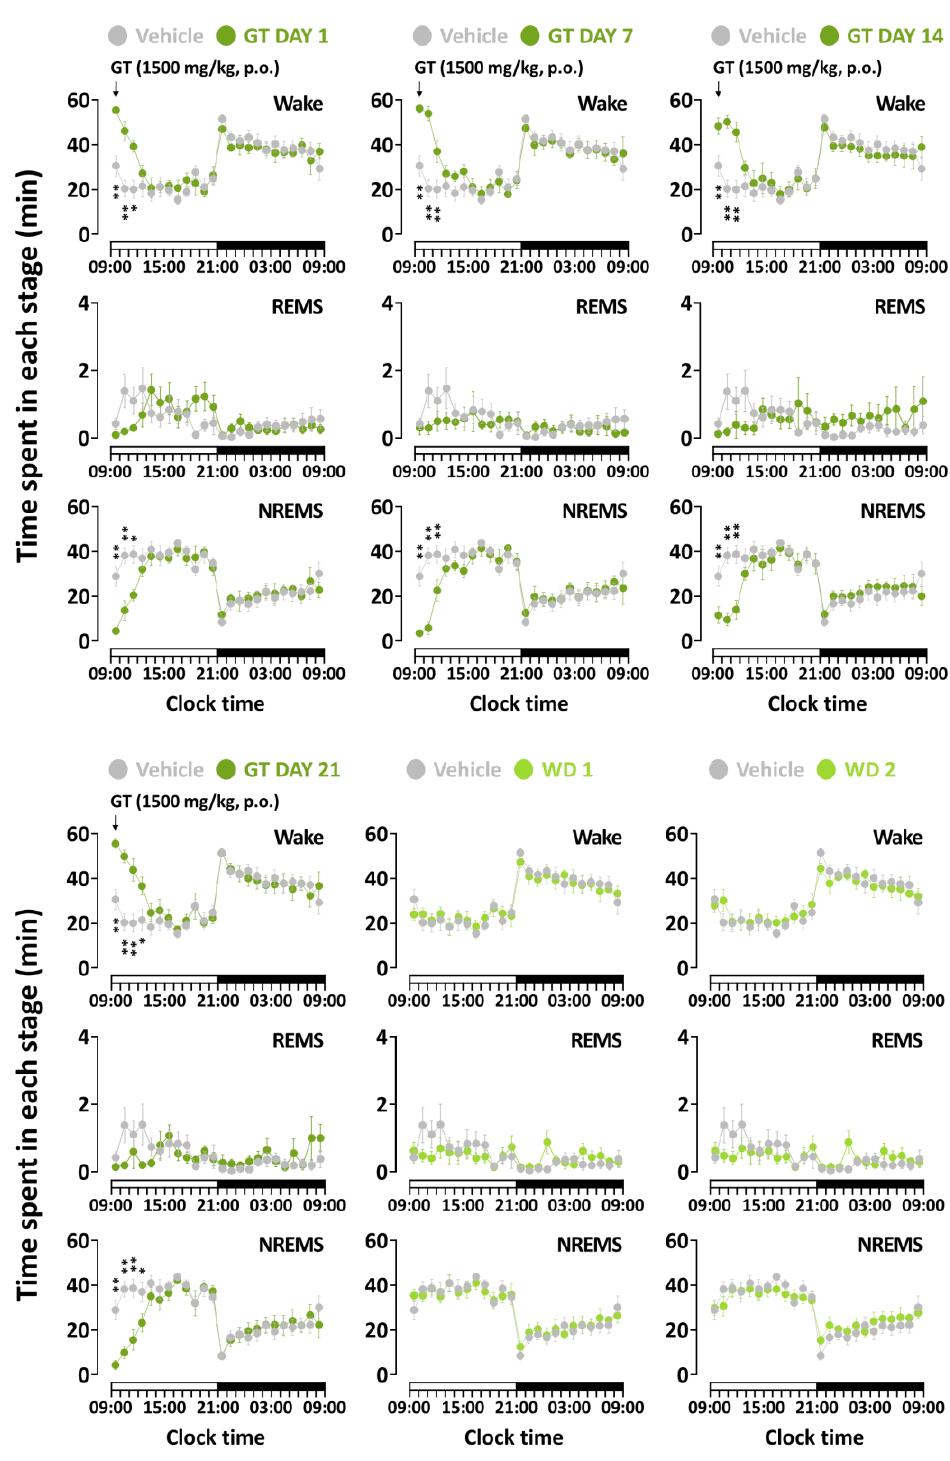
Figure 4. Time-course changes of GT (1500 mg/kg) treatment during each stage over the whole administration period. Grey circles indicate the baseline day (vehicle). Green circles illustrate GT treatment. Light green circles illustrate the withdrawal (WD) day during the end of GT treatment. Every circle denotes the hourly mean ± SEM ( n = 7 – 8) in each stage. * p < 0.05, ** p < 0.01 indicate significant differences compared to the vehicle (Dunnett’s test). BL, ba seline; GT, green tea ethanol extract; NREMS, non-rapid-eye-movement sleep; REMS, rapid-eye-movement sleep; Wake, wakefulness; SEM, standard error of the mean.